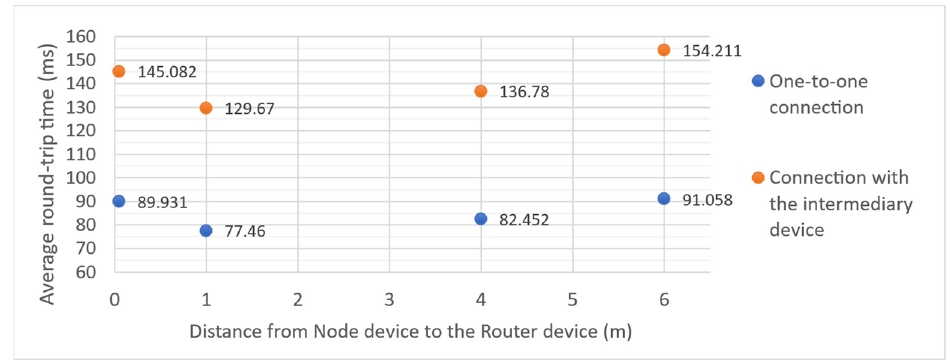
Figure 12. 6LowPAN BLE transmission delays measured in the test network using Ping network utility. The measurement was performed 200 times in each configuration. The points presented on the chart correspond to the averages of the obtained results.